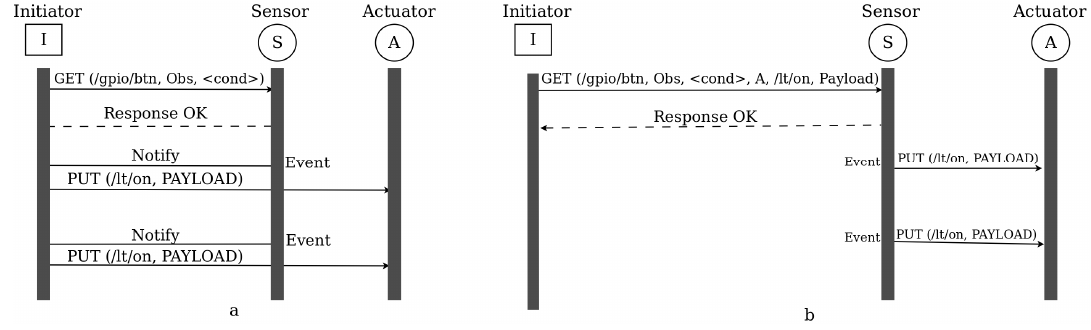
Figure 5. Flow Chart Showing Binding Relationship Establishment.